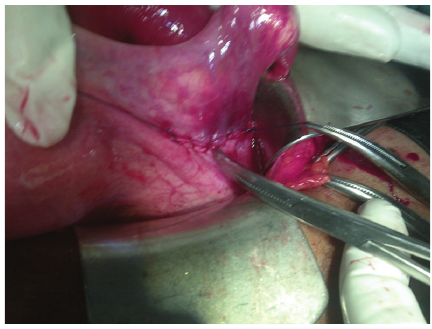
Figure 4: Postrepair of broad ligament